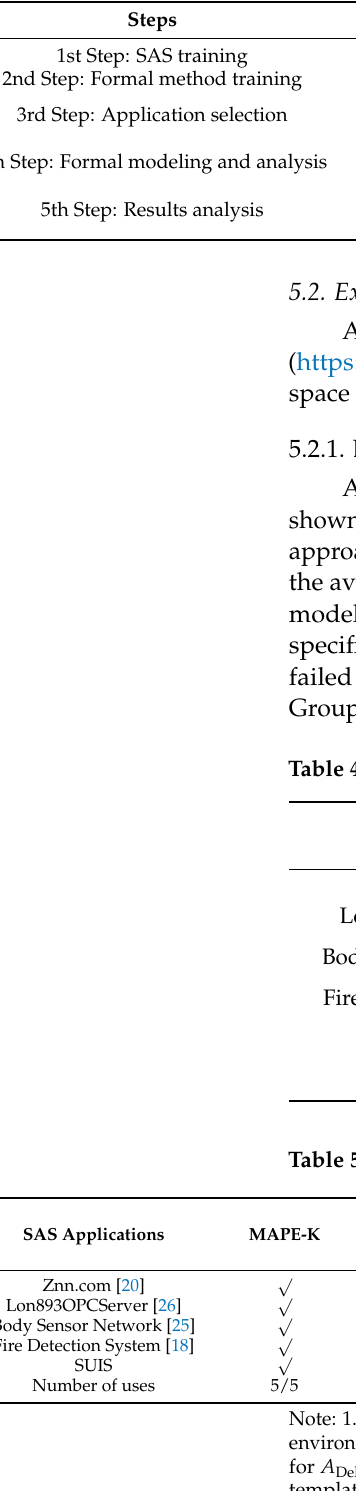
Table 3. Design of the experiment.